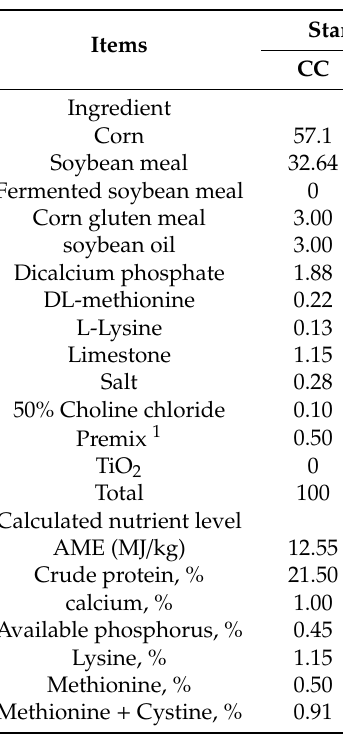
Table 2. Composition and nutrient levels of experimental diets (air-dry basis,